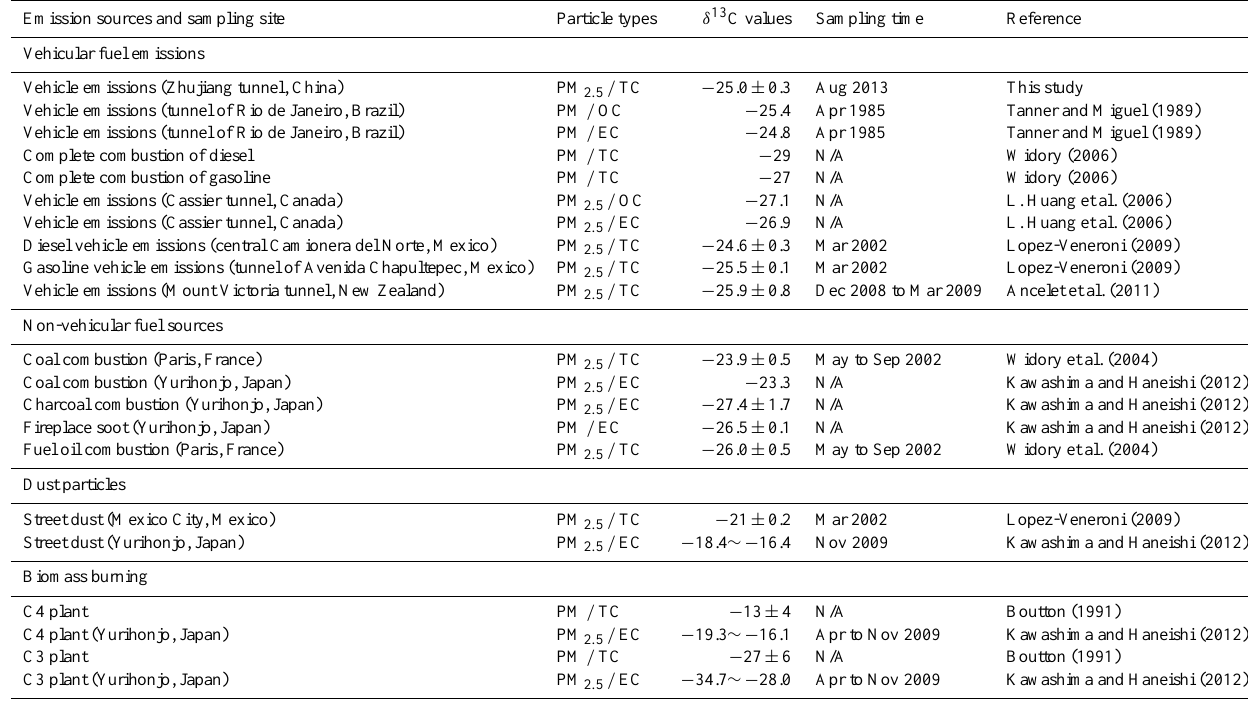
Table 1. δ 13 C values (‰) of PM from vehicle emissions in this study and other emission sources.